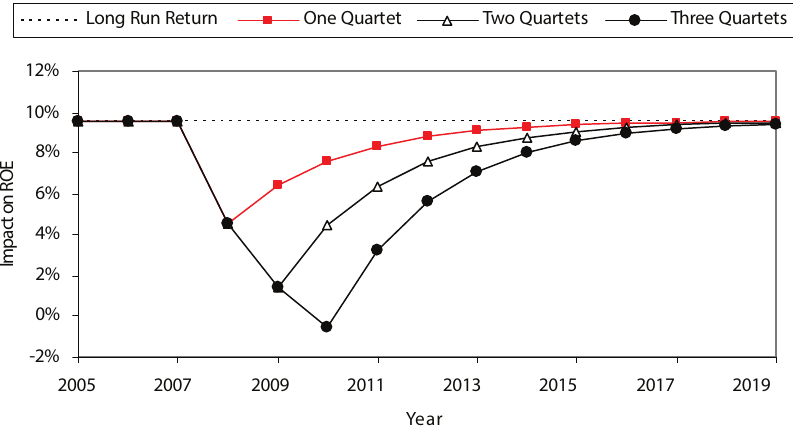
Figure 1. Response of Return on Equity to one (observed) and more Quartet-scale storm loss scenarios. The area under the un-impacted profile is proportional to the damage (the complement of the area can be construed as the “learning” information volume) and the slope of the response function as the speed of recovery of the